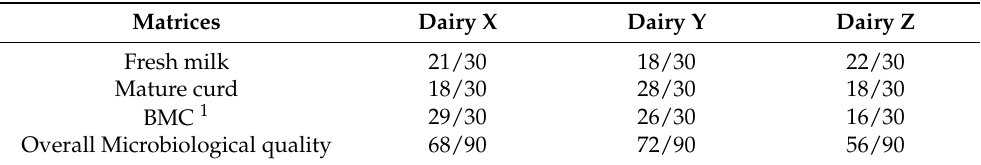
Table 2. “Single Scores” and “Overall Microbiological quality” of selected matrices for each dairy. Matrices